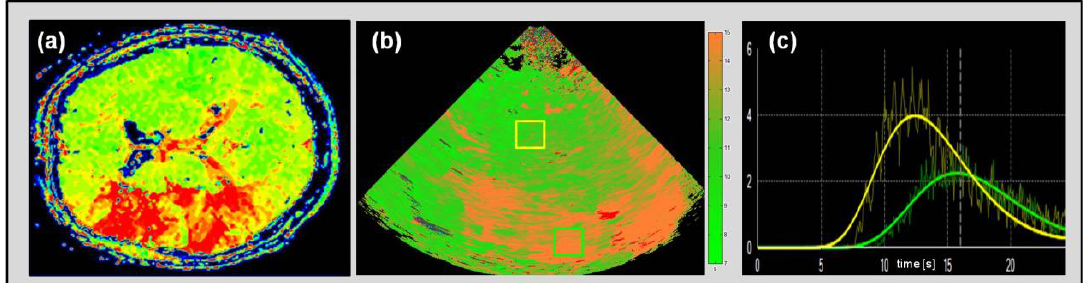
Figure 6. Perfusion MRI time-to-peak (TTP) map of an acute stroke patient with expanded penumbral perfusion delay in the territory of the middle cerebral artery (MCA) omitting basal ganglia ( a ). Ultrasonic cerebral perfusion imaging UPI parametric image with a corresponding depiction of time-to-peak intensity (TPI) delay in the MCA territory omitting basal ganglia ( b ). Exemplary depiction of ROI-wise course-of-time intensity curve in normal perfused brain tissue (yellow curve corresponding yellow box in ( b ) in basal ganglia of the unaffected hemisphere) and penumbral tissue (green curve and box) in an acute stroke patient with MCA occlusion and apparent collateral compensation.